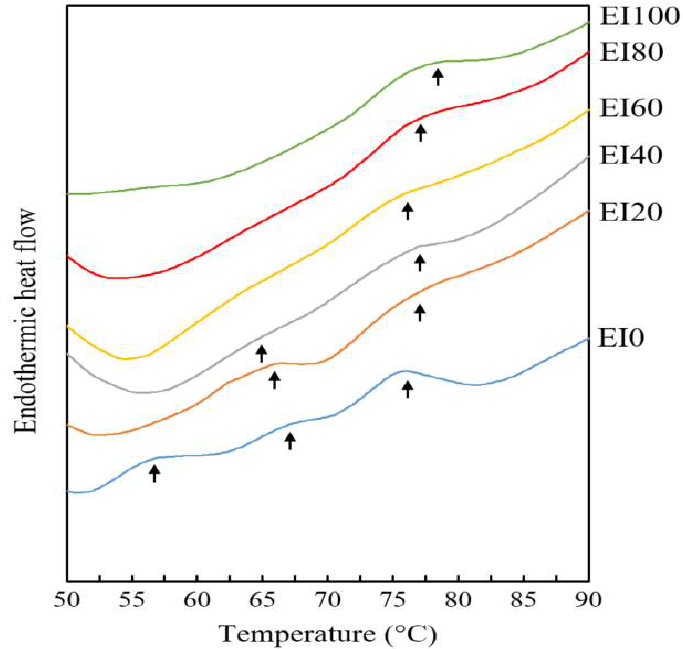
Figure 3. Endothermic heat flow of emulsion prepared with the interaction between porcine myofibrillar protein and extracted edible insect protein. Porcine myofibrillar protein was substituted by edible insect protein at 0, 20, 40, 60, 80, and 100% (EI0, EI20, EI40, EI60, EI80, and EI100, respectively).